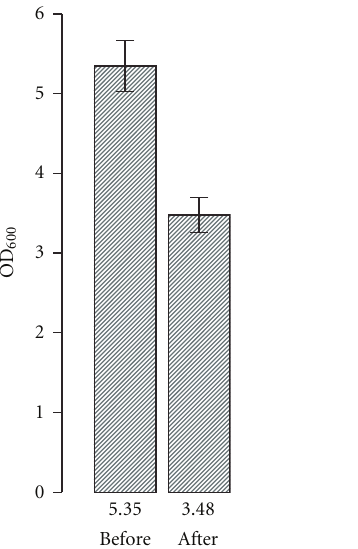
Figure 4: Light scattering by intracellular gas vesicles. Vacuolated cells were centrifuged at 5000 xg for 5mins to deflate gas vesicles. OD 600 and CFU counts were taken before and after centrifugation. No decrease in CFU or change in morphology were observed before and after centrifugation meaning that di ff erence in OD 600 can be directly attributed to gas vesicle loss. Error bars represent + / − one standard deviation of the quadruplicate measurements. OD 600 values are included below each column as reference.